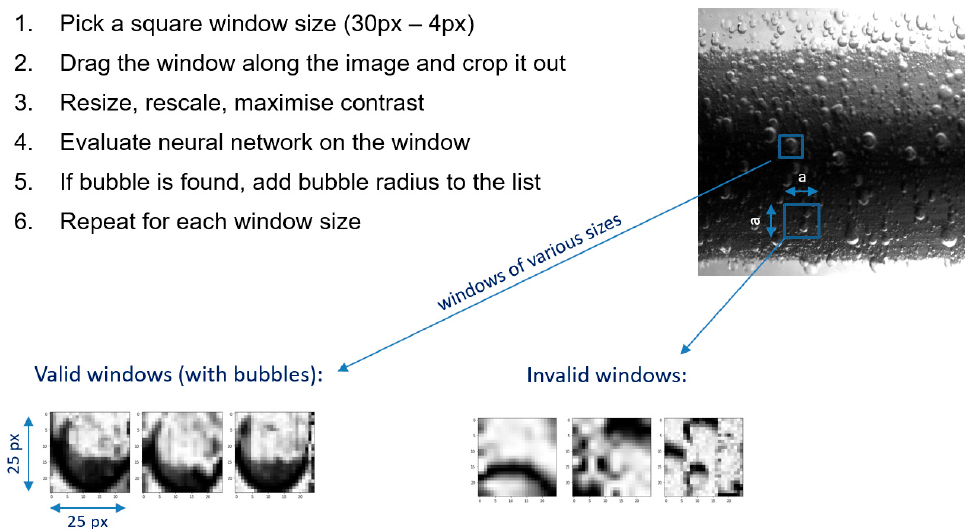
Figure 6. Bubble detection “window-dragging” algorithm utilizing a neural network to detect bubble bounding boxes.